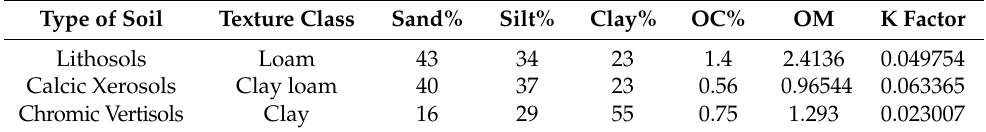
Table 4. K factor, type, texture, and organic material content of the three soil types.